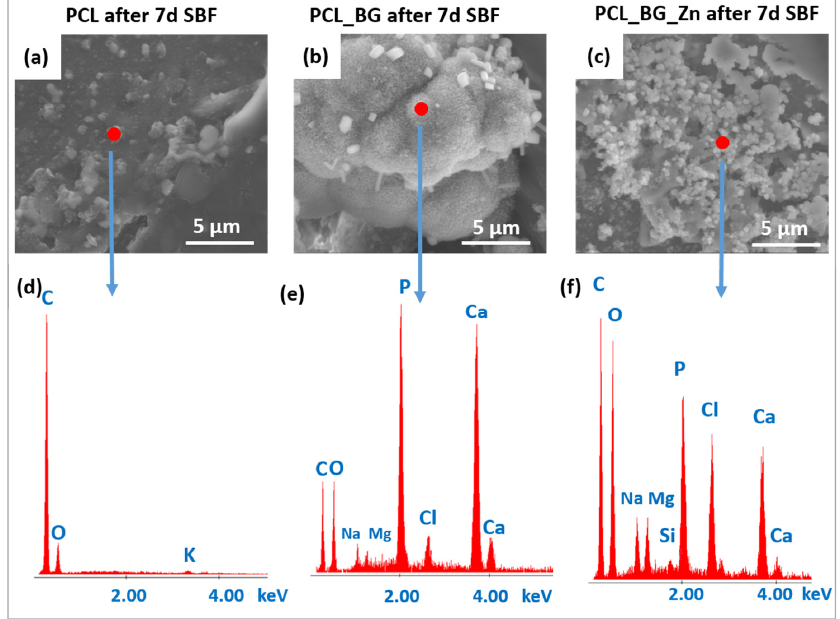
Figure 6. SEM micrographs of ( a ) PCL; ( b ) PCL_BG; ( c ) PCL_BG_Zn scaffolds after 7 days of incu- bation in SBF. EDX analysis of the aforementioned samples ( d , e , f ).